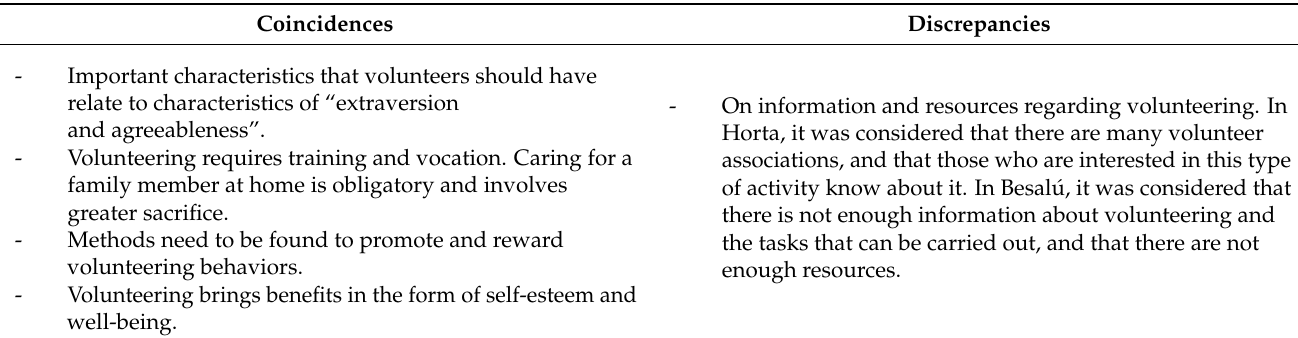
Table 8. Coincidences and discrepancies in the opinions between the participants from the two senior citizens’ activity clubs. Coincidences